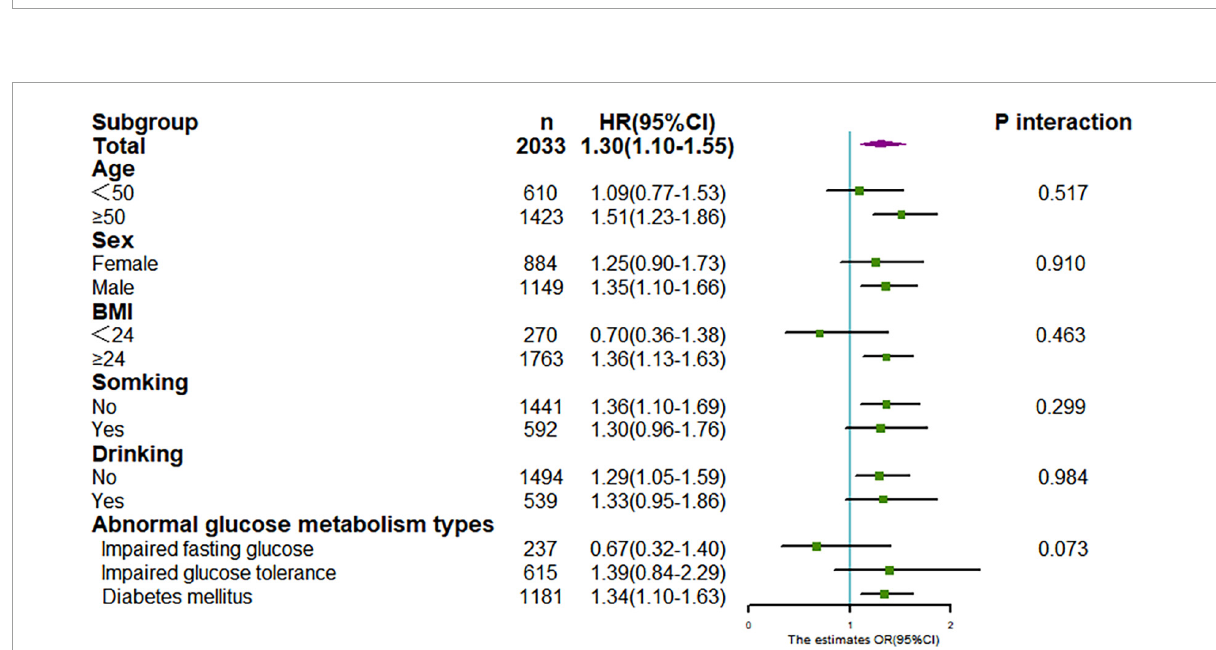
FIGURE5 Stratification analysis on association between TyG with CKD. Results were derived from multivariate Cox regression and presented as hazard ratio (adjusting covariates: sex, age, smoke, drink, BMI, duration of hypertension, duration of diabetes, SBP, DBP, LDL-C, HDL-C, Cr, BUN, UA, lipid-lowering drugs, antidiabetic drugs, and antihypertensive